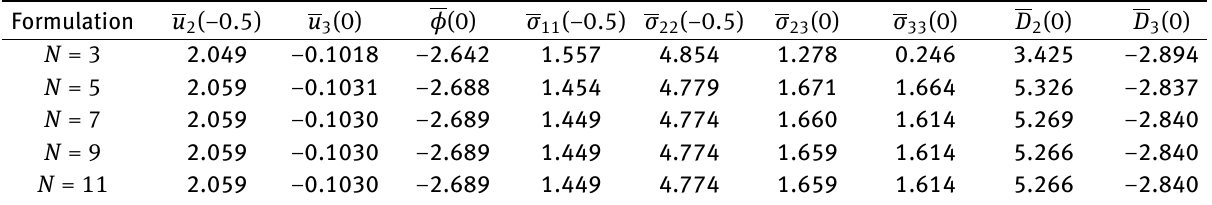
Table 6: Results for a FGM piezoelectric thick cylindrical shell with R / h = 7.725 and α = 1 using 16 × 64 mesh. Formulation